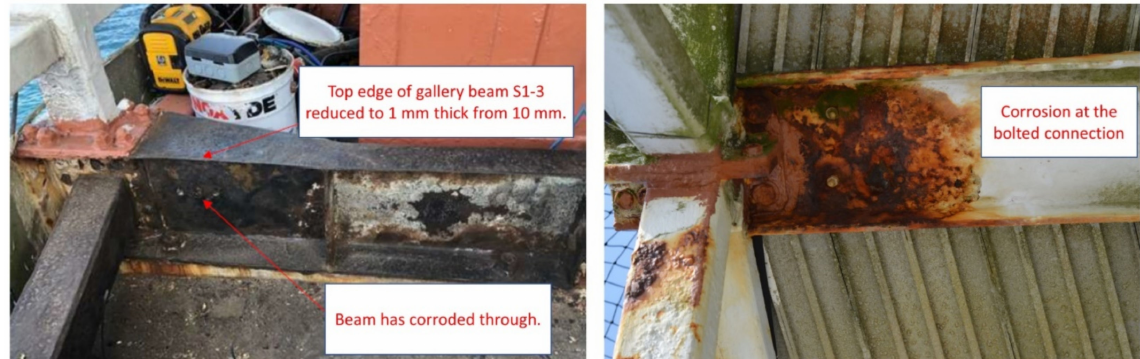
Figure 4. Examples of corroded areas of the helideck [courtesy of Trinity